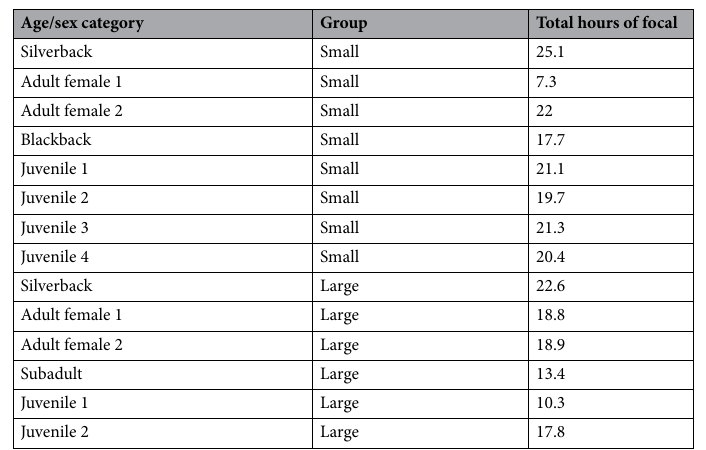
Table 1. Total hours of focal animal sampling per each group member of the two study groups. Age/sex categories are as defined by 86 (Juvenile: 4–7.5, Subadult: 7.5–11, Blackback: 11–14, Young Silverback: 14–18, Adult Female: > 10 yr and Silverback: > 18 yr). Real group compositions a) Small group (CAR1): one silverback, two adult females, one blackback, four juveniles and one infant, and b) Large group (CAR2): one silverback, four adult females, three sub-adults, four juveniles and three